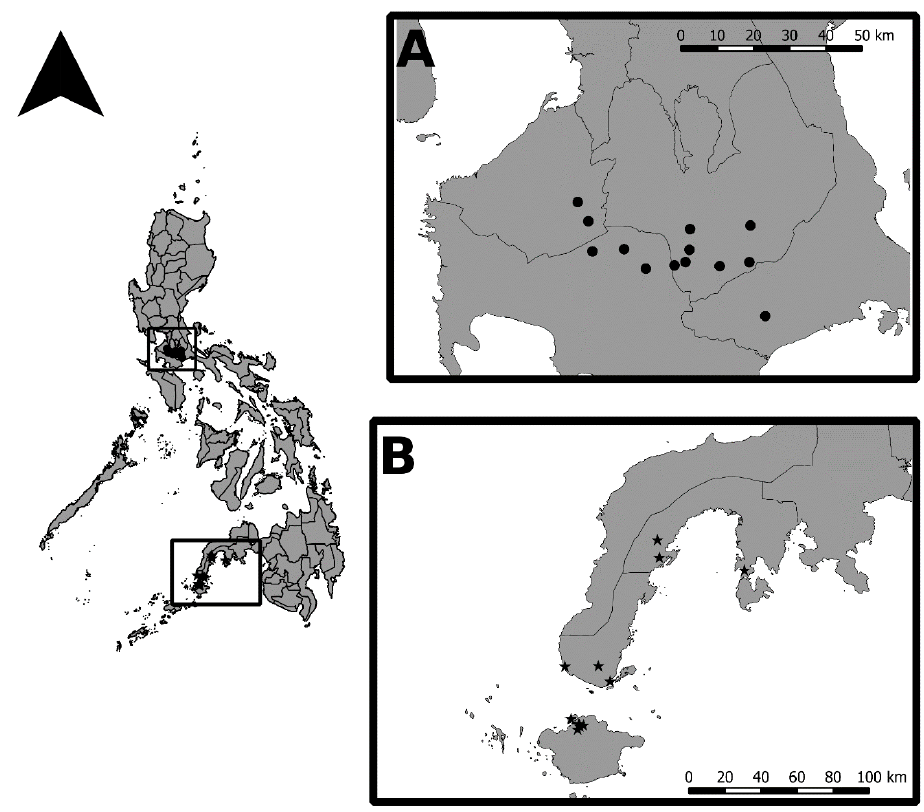
Figure 1. Selected sites in the Philippines with confirmed occurrence of Aspidiotus rigidus and Comperiella calauanica : ( A ) Southern Tagalog and ( B ) Zamboanga Peninsula.